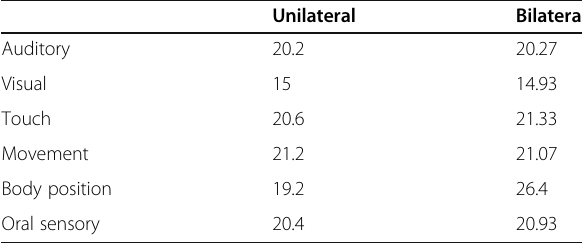
Table 3 Comparison between mean scores of sensory sections in children with unilateral and bilateral SCP Unilateral Bilateral Auditory